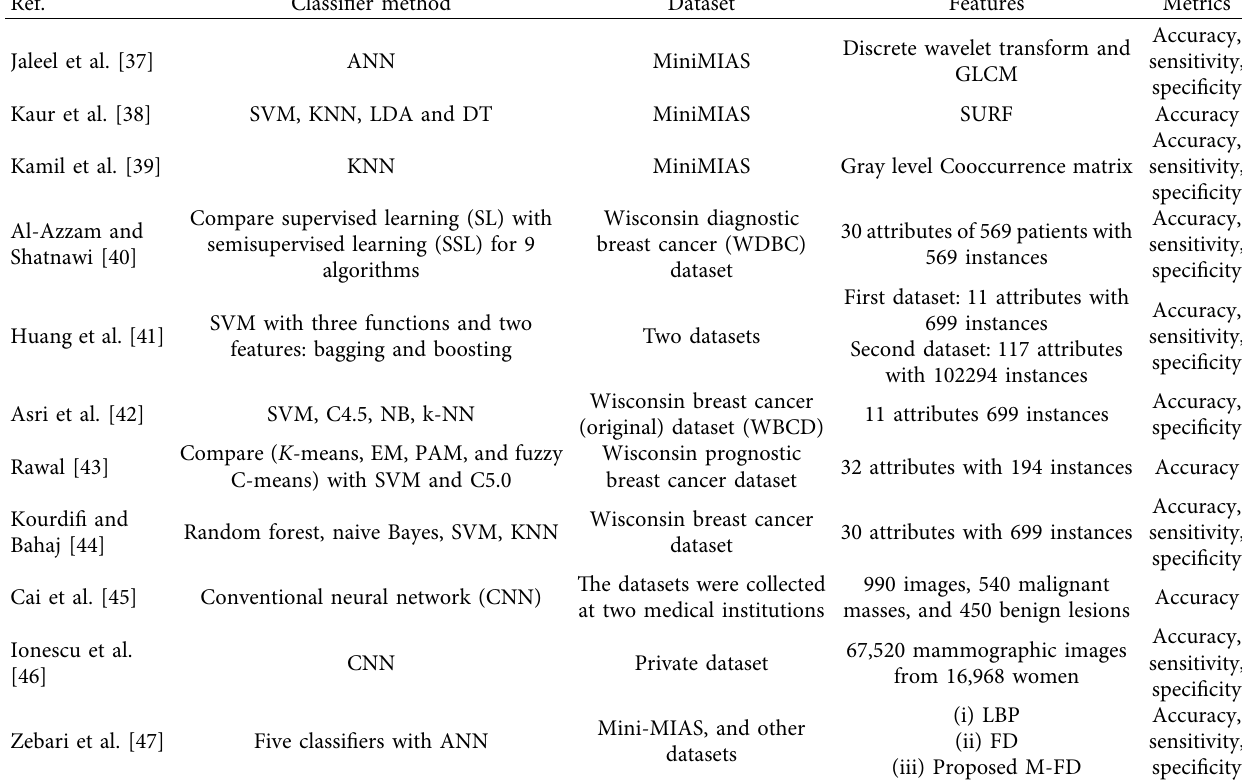
Table 1: Related works that are carried out for proposing CAD systems for breast cancer.